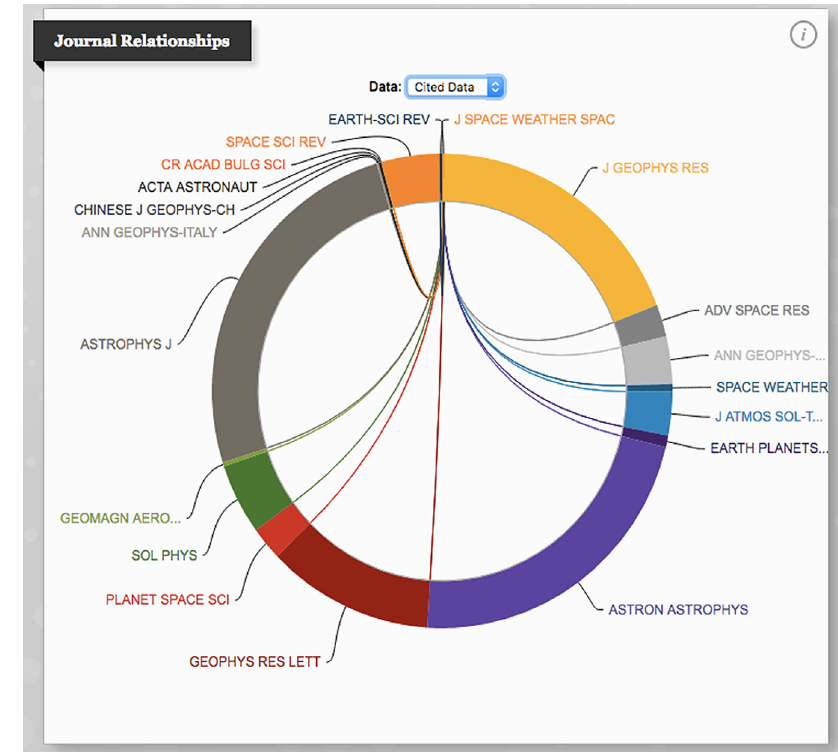
Fig. 1. Journals where SWSC articles are cited (Source ‘‘powered by InCites-Clarivate Analytics’’).